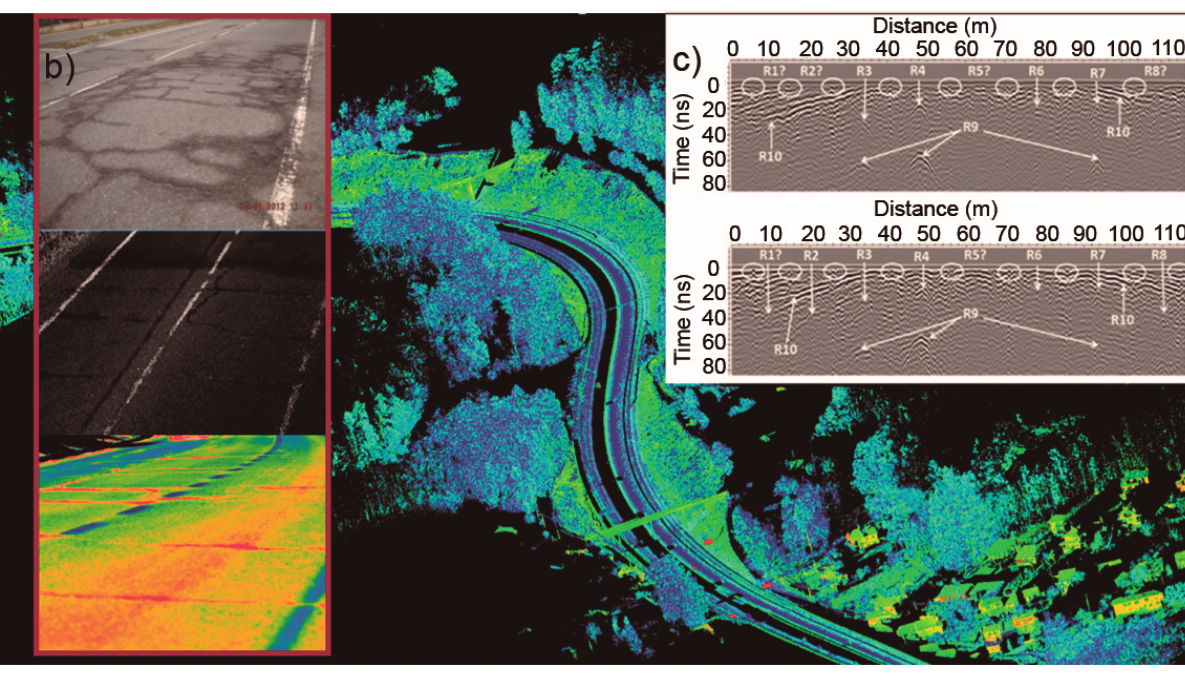
Figure 10. ( a ) View of a point cloud of a highway; ( b ) visualization of cracks on the pavement through a visible image, point cloud and thermogram; ( c ) 2D radargrams acquired on a bridge that show the characteristics of the internal structure of the